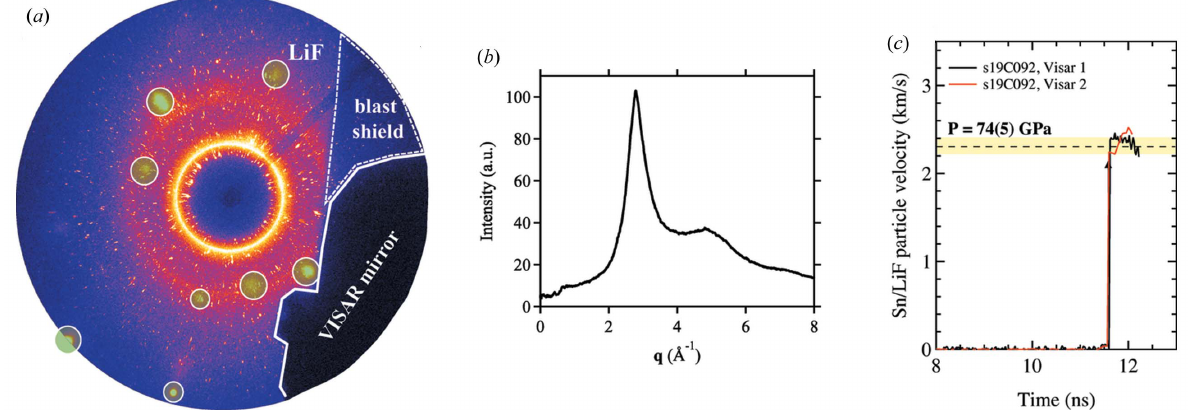
Figure 4 ( a ) Raw diffraction profile collected at DCS. Single-crystal spots from the LiF window material, which are masked from the integrated profiles, are highlighted by green circles. All remaining spots are ambient (cid:10) -Sn peaks (ambient material ahead of the shock wave) that are also removed from the final integrated profile, leaving only the diffuse scattering from liquid tin. The X-ray shadows from the VISAR mirror and blast shield are also highlighted. ( b ) Partial azimuthally integrated intensity as a function of momentum transfer from ( a ) ignoring the areas with shadows from the blast shield and the VISAR mirror. The beam energy used for converting from 2 (cid:3) to q was 23.53 keV. ( c ) Point VISAR data. The dashed line shows the average Sn/LiF particle velocity at shock breakout, with uncertainty bounded by the yellow shaded region; the shock pressure of 74 (5) GPa is determined using impedance matching of the Sn sample with the LiF window. The arrow indicates the time at which there is a significant loss of